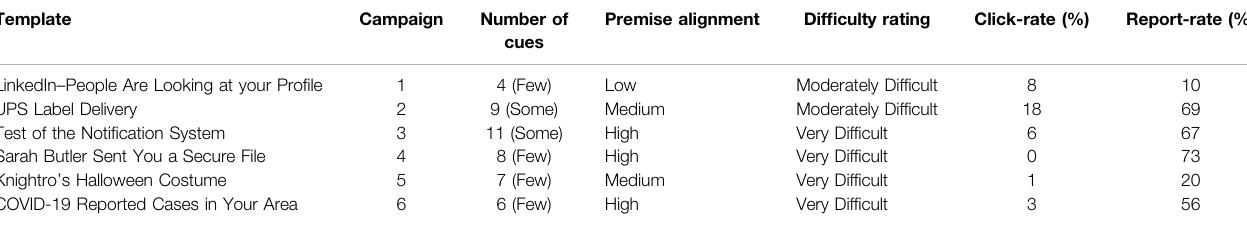
TABLE 1 | Email template phish scale dif fi culty with click and report rates.